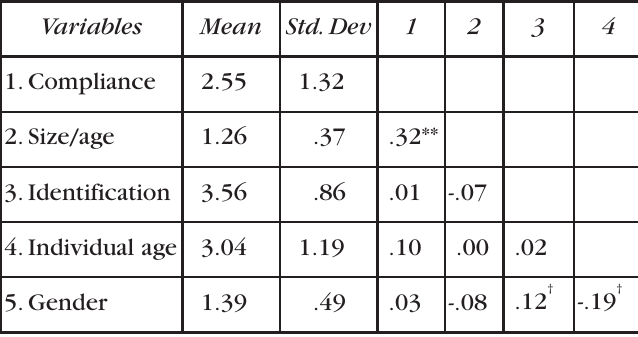
Table 1. Means, Standard Deviations, and Correlations Variables